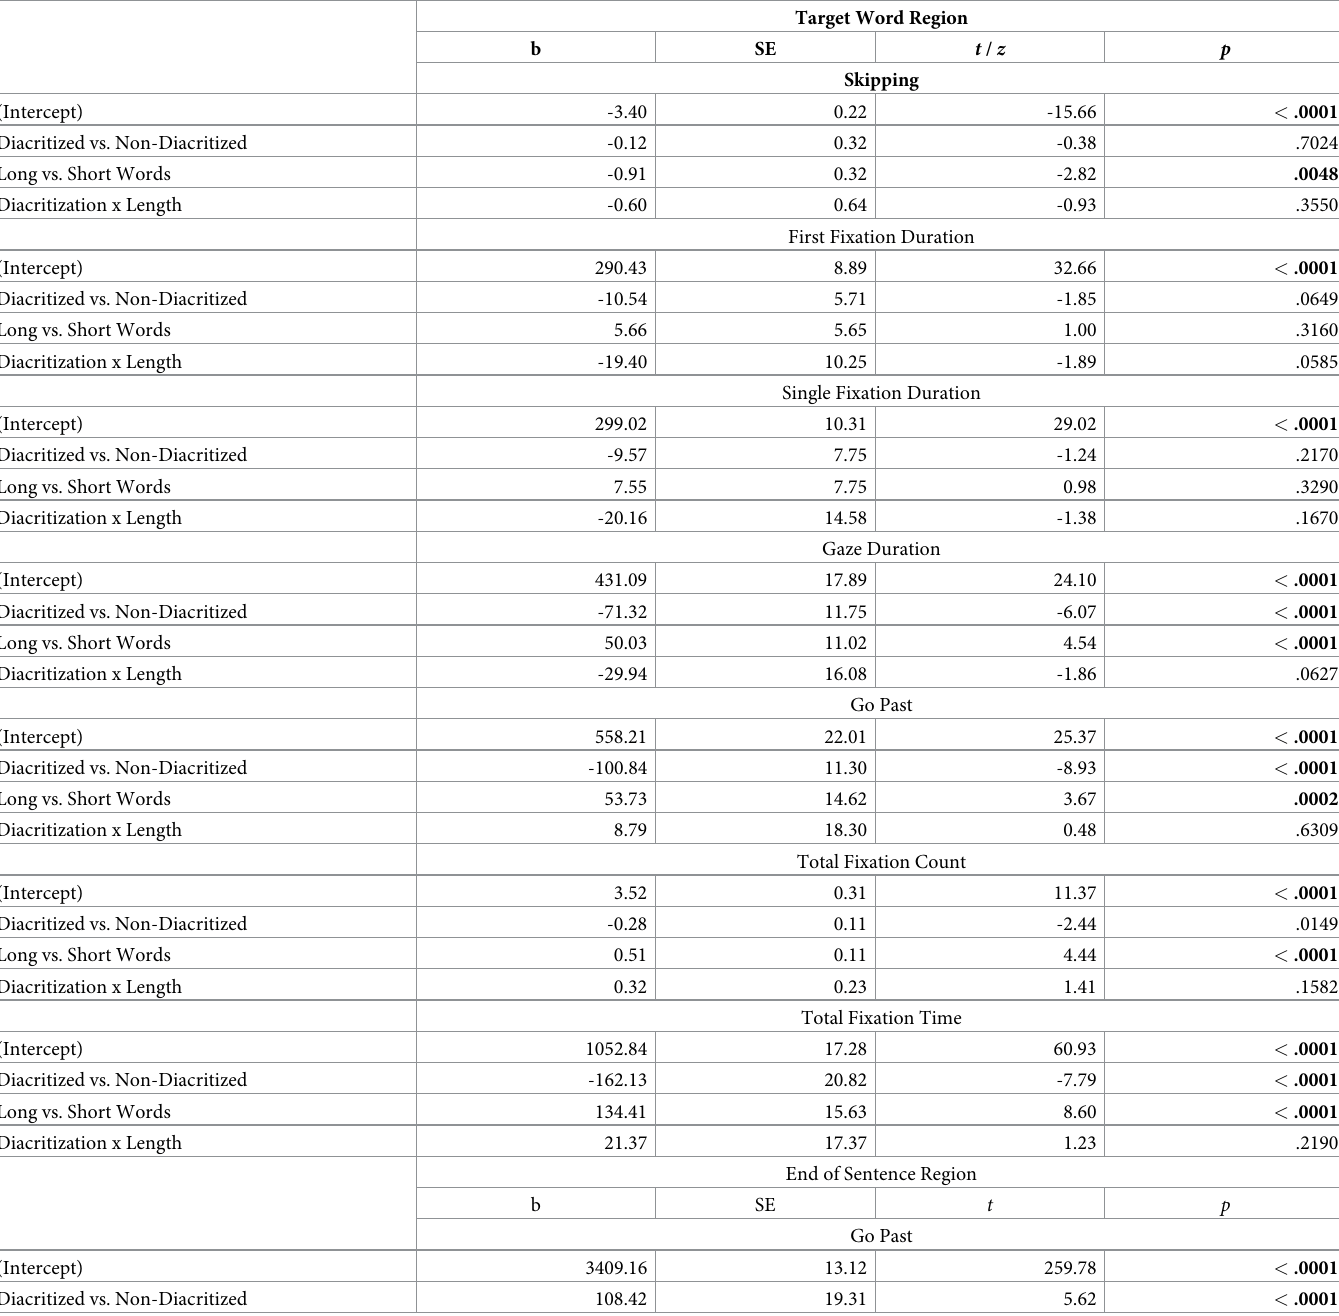
Table 4. GLMM output for eye movement measures (experiment 2 –word length ×